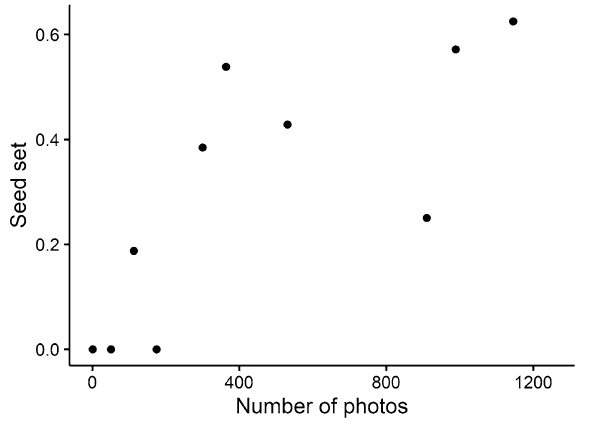
Figure 3. Relationship between the number of photos of flower-visiting bees on Day 2 and seed set (number of mature seeds divided by ovule number in a flower).